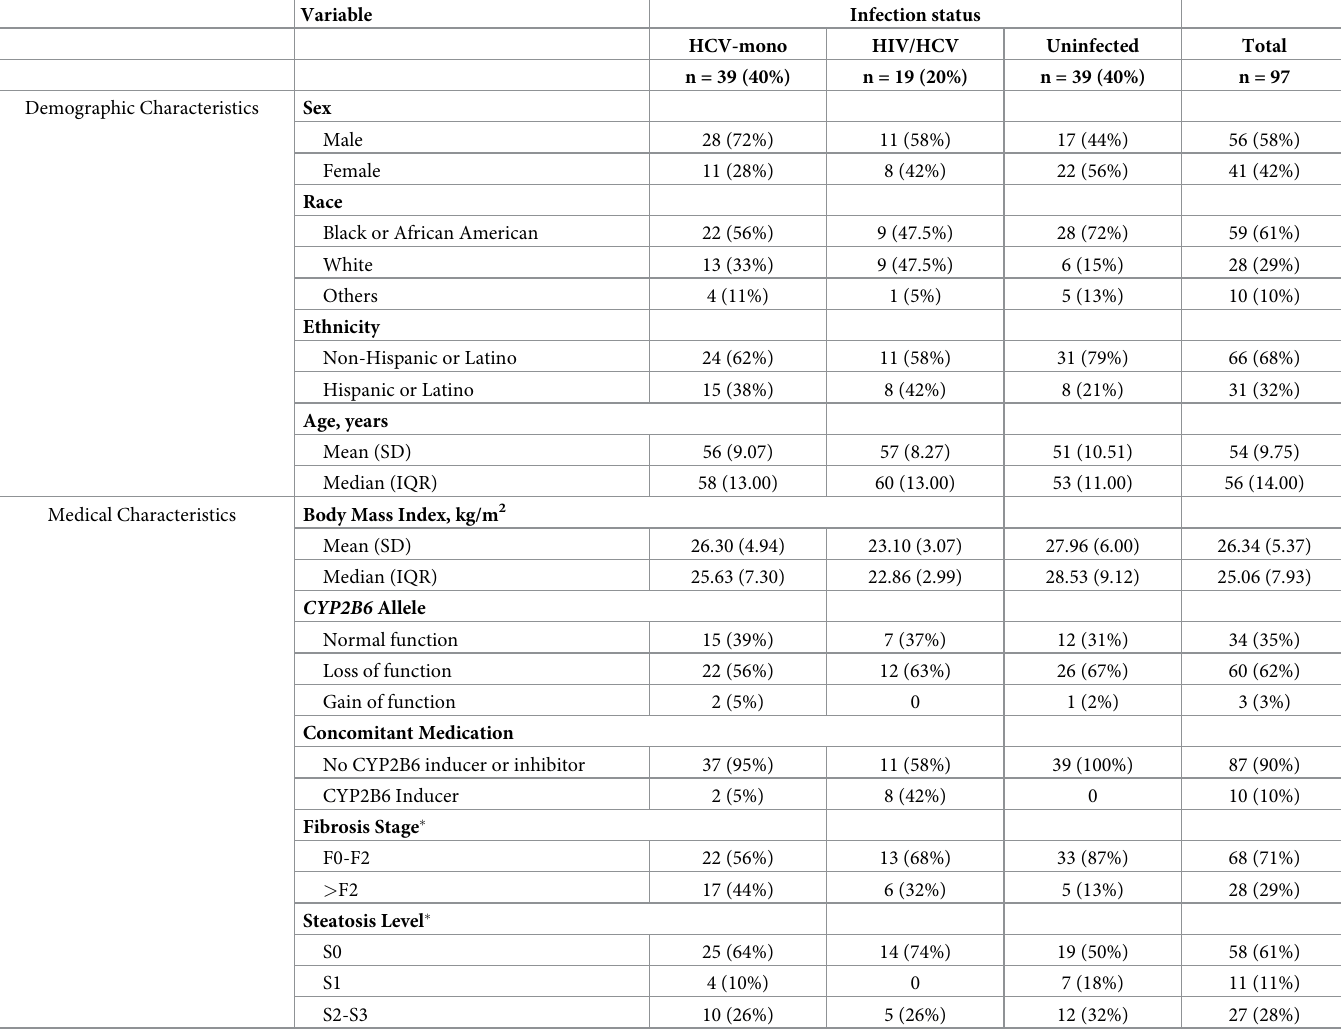
Table 2. Demographic and medical characteristics of the study participants. The table presents counts and associated percentages or mean, median and associated standard deviation (SD) or interquartile range (IQR) as